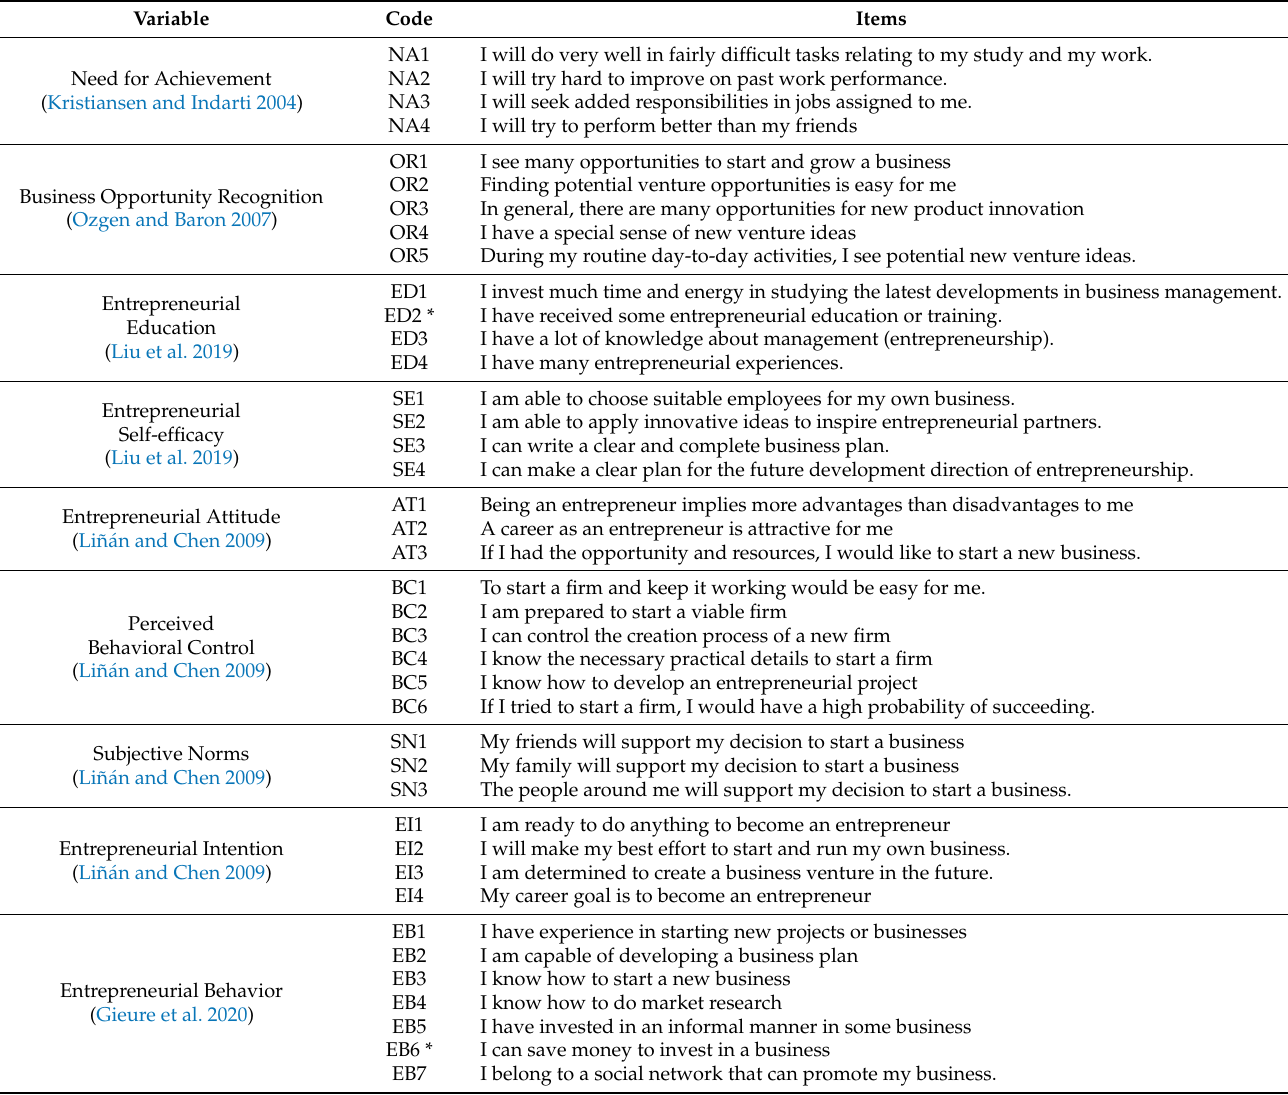
Table A1. Variables and items used in this